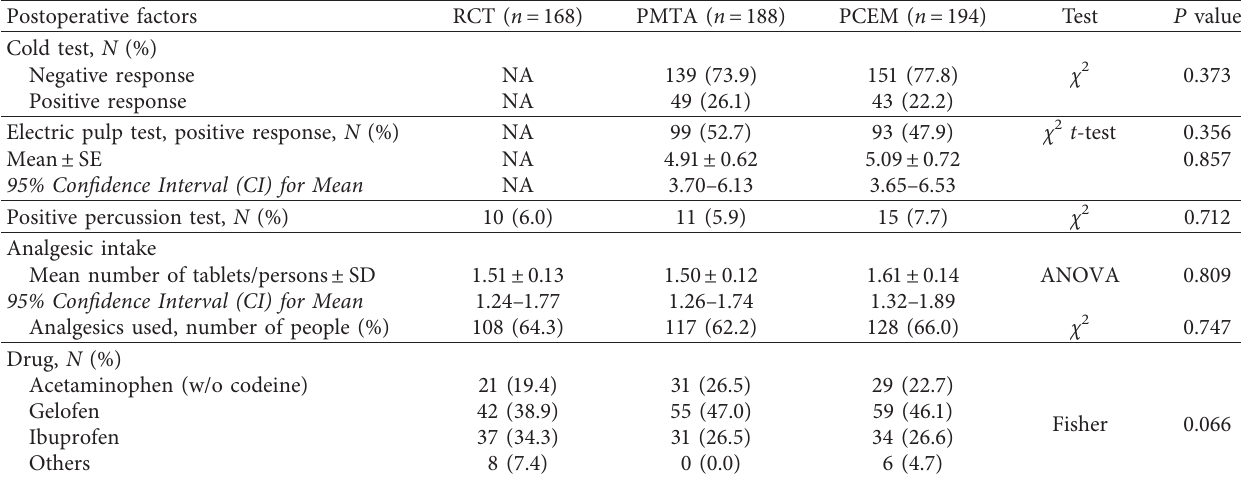
Table 4: Comparison of postoperative conditions in the three study arms.